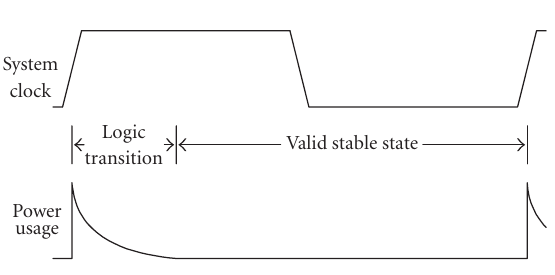
Figure 9: Single-phase clock power